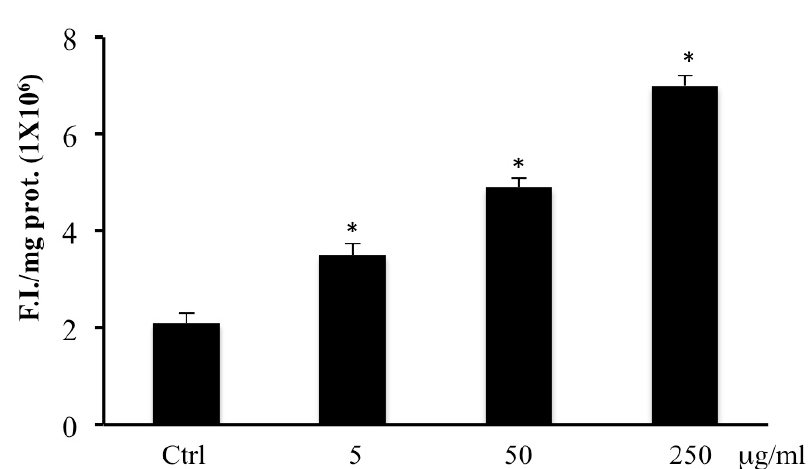
Figure 3. Intracellular oxidants in CaCo2 cells untreated and treated for 72 h with methanolic extract of B. etnensis Raf. at different concentrations (5–250 µg/mL). Values are the mean ± SD of four experiments in triplicate. *Significant vs. untreated control cells: p < 0.001.